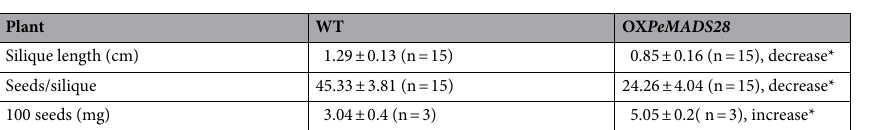
Table 1. Silique length and seeds in OX PeMADS28 transgenic plants and wild-type (WT) plants. Asterisks indicate statistically significant differences (*P < 0.05 compared with WT by Student’s t-test); The ± standard deviation (SD) of the three biological